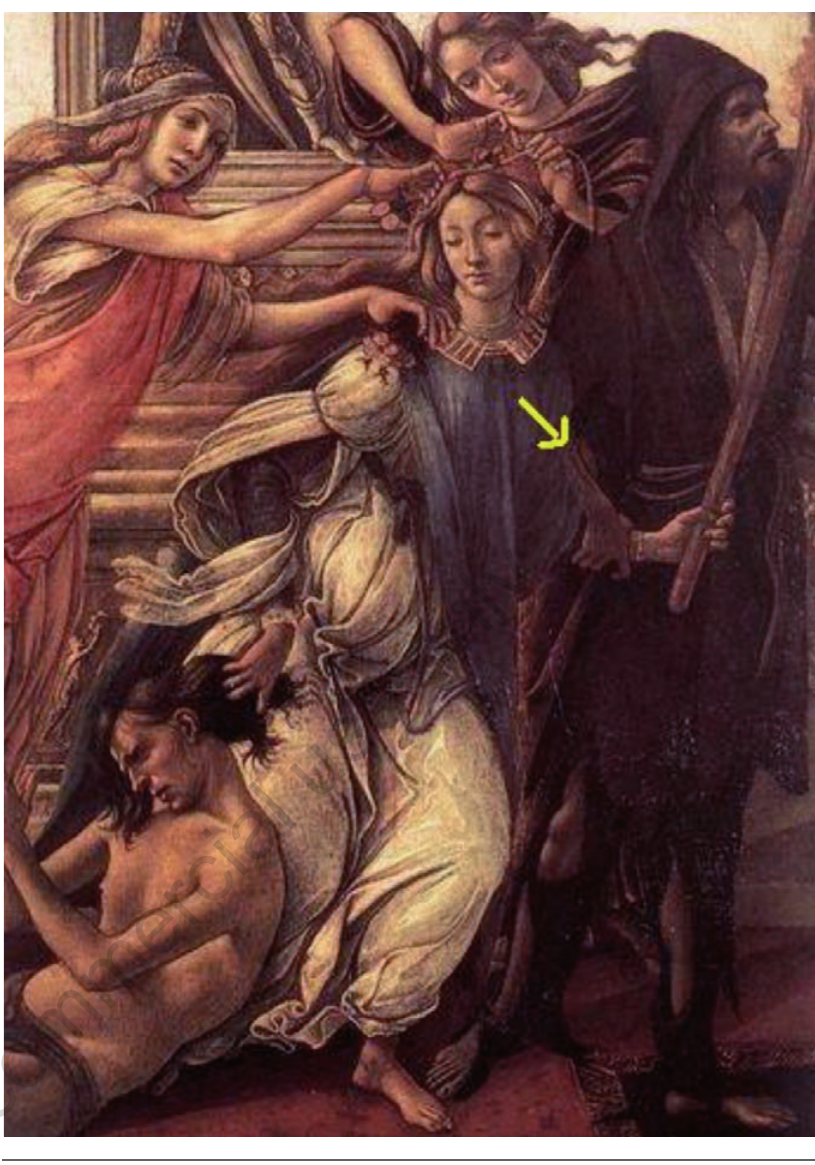
Figure 2. The profile of Envy. Note wasting in extensor aspect of forearm, weak grip of right hand (yellow arrow) and wasted calf